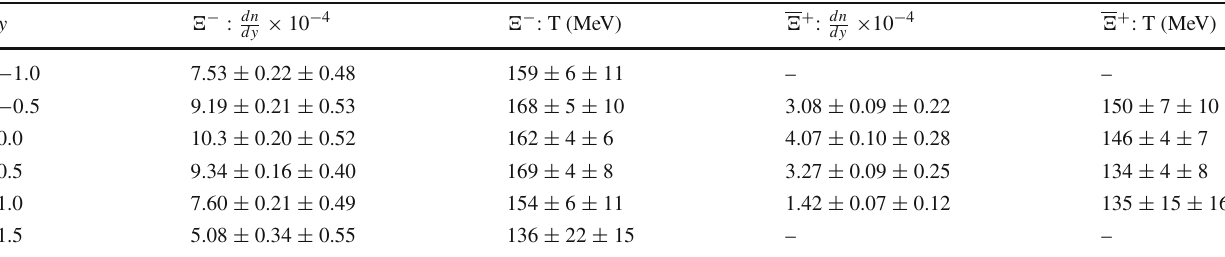
Table 4 Numerical values of rapidity spectra of (cid:2) − and (cid:2) + produced in inelastic p+p interactions at 158 GeV / c beam momentum and fitted inverse slope parameter T (see Eq. 3). Rapidity values correspond to